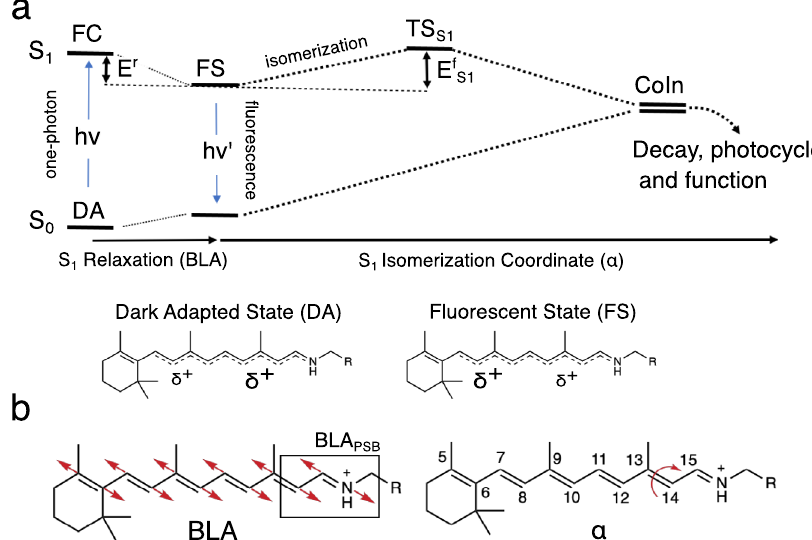
Fig. 1 | Geometrical and electronic structure changes in NeoR. a Schematic representation of the hypothetic S 0 and S 1 energy changes occurring along the S 1 relaxation that involves the bond length alternation (BLA, quanti fi ed by the dif- ference between the average of the double-bond lengths and the average of the single-bond lengths of the conjugated chain) and isomerization ( α ) coordinates. The rPSB resonance hybrids show a delocalized positive charge at the S 0 and S 1